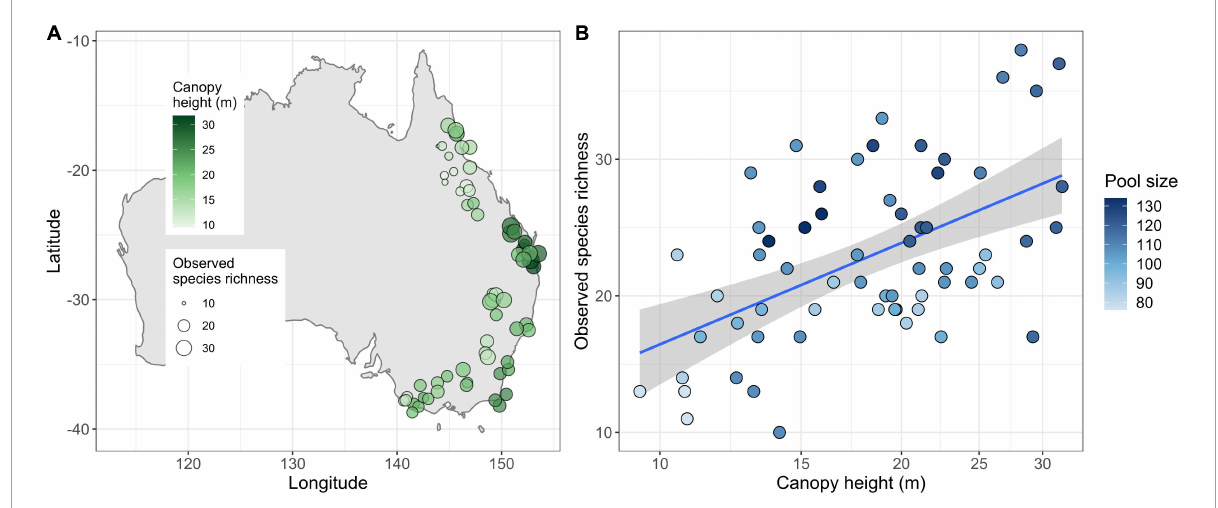
FIGURE1 Canopy height, species richness, and pool size in eastern Australia. (A) Map of Australia showing the location of our 63 transects (their geographic position was randomly jittered to decrease point overlap). The latitudinal span of the sites is ca. 2,300 km, while the span along the coast is ca. 3,000 km. (B) Observed species richness increased with both canopy height and size of the regional species pool (note that light-colored pool points lie mostly below the regression line and vice versa for dark-colored points). Here, observed species richness and ecological species pool are depicted. Other options (Chao2 richness, and biogeographic and internal pool) showed almost identical